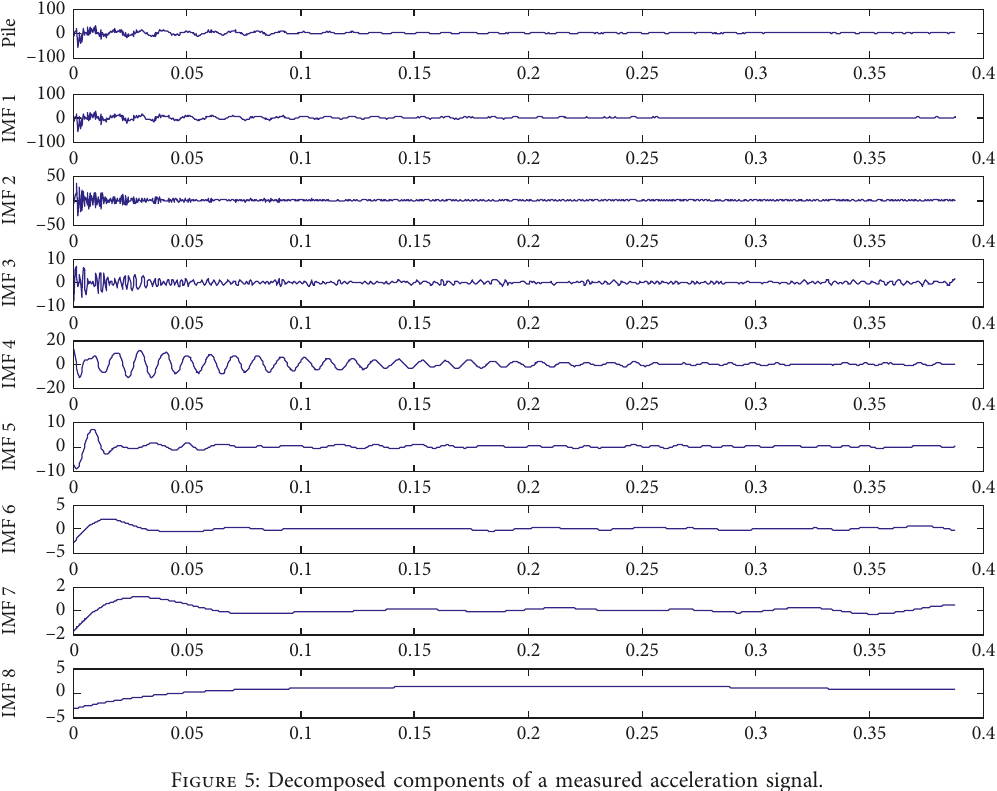
Thus, the damped natural frequency ω dj can be ob- t tained from the slope of the phase angle plot in ω j ( ) versus t, and ς j can be obtained from the slope of the plot in ln a ij versus t . The linear least-squares method can be used to fit the t plots of ln a ij versus time and ω j versus time. The fol- ( ) lowing section illustrates the signal decomposition and parameter identification by using the measured acceleration